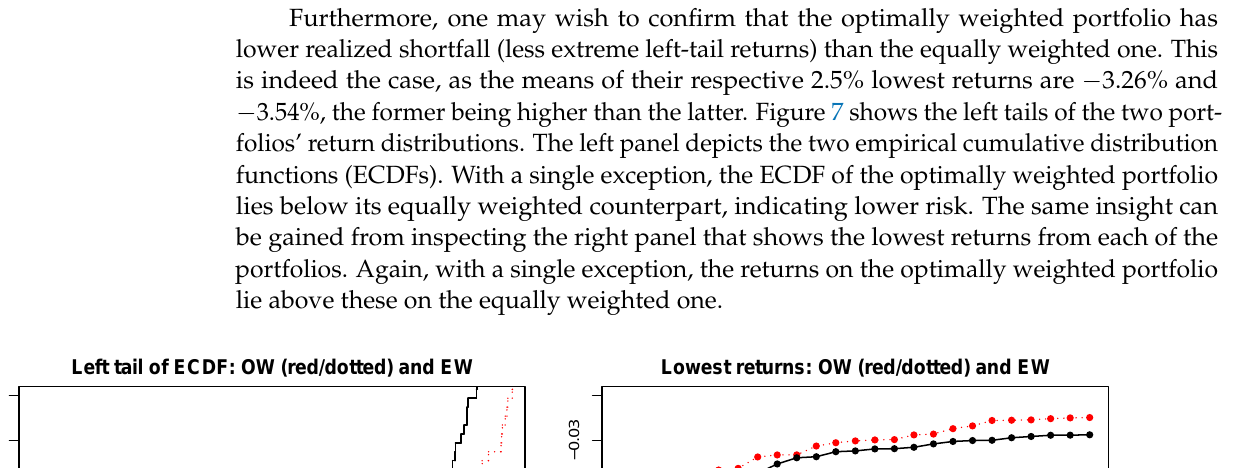
Figure 6. Cumulative returns on the optimally weighted (OW) portfolio on the left. Difference between the cumulative returns on the OW and the equally weighted (EW) portfolio on the right. (Transaction costs not accounted for).